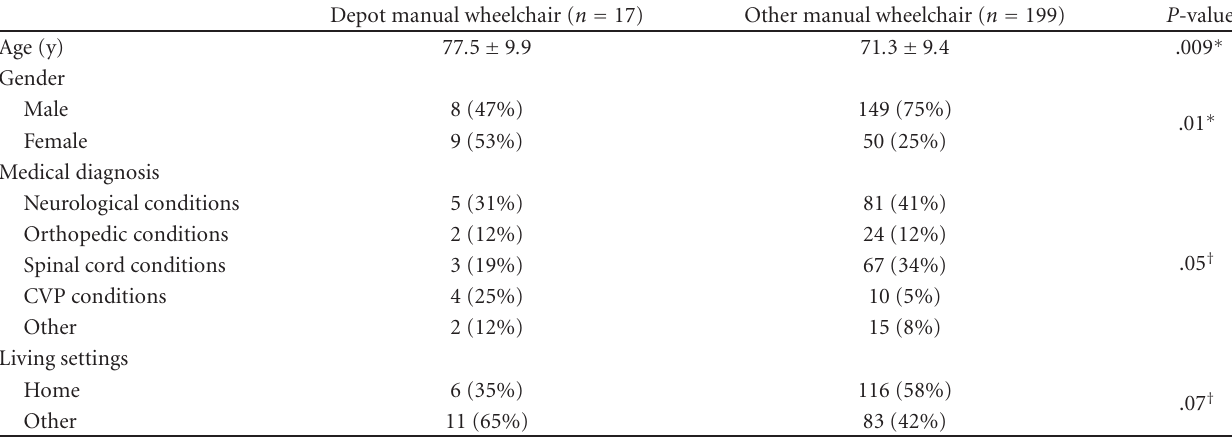
Table 3: Tier 2: Factors associated with use of depot versus other manual wheelchairs.